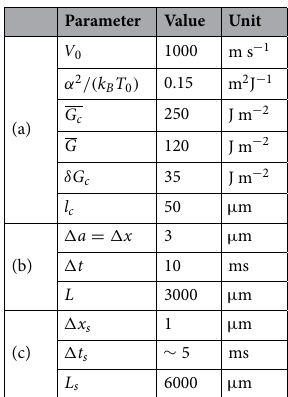
Table 1. Summary of all parameters that are considered in this manuscript. (a): physical parameters in Eqs. (1) and (2) believed to be representative of the studied creep experiments. (b): observation scale of the modelled fronts, similar to the experimental ones of Tallakstad et al. 28 . (c): the solver grid, finer than the observation scale for numerical